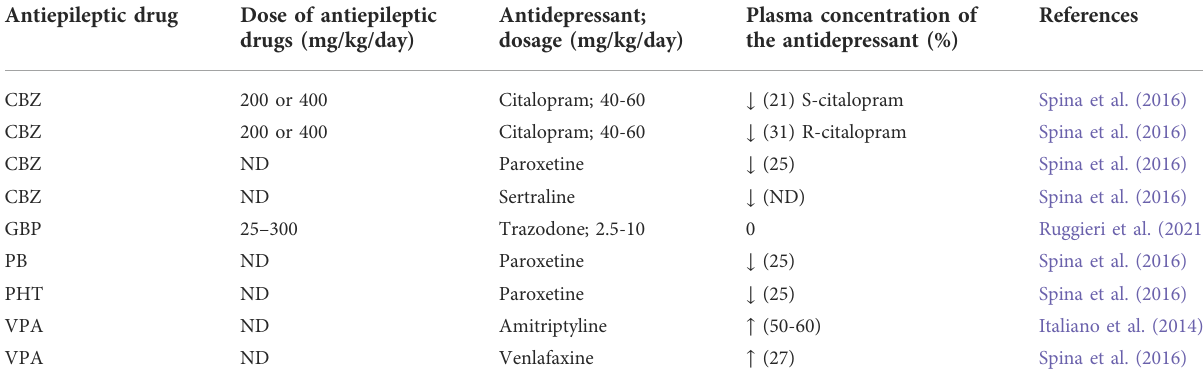
TABLE 3 Pharmacokinetic interactions between antiepileptic and antidepressant drugs. Antiepileptic drug